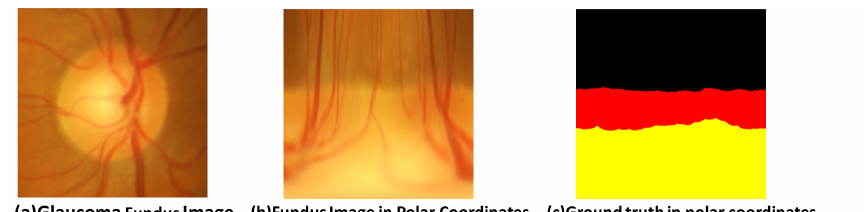
Figure 3. An example of segmentation using polar coordinates. ( a ) Glaucoma fundus image. ( b ) Fun- dus image in polar coordinates. ( c ) The ground truth in polar